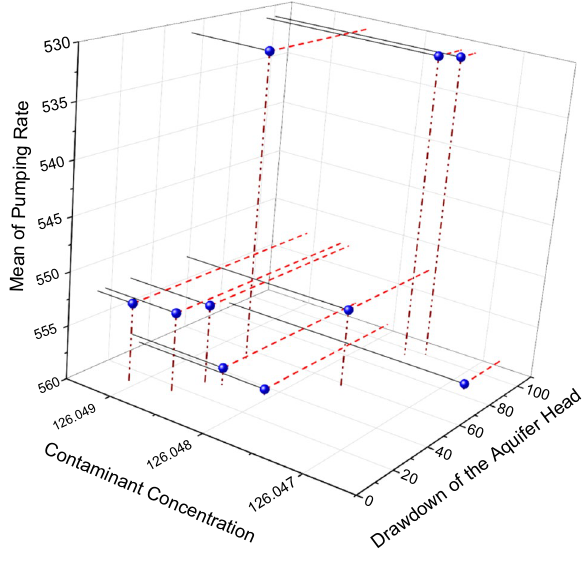
Fig. 17 Pareto front of NSGA-II algorithm (Real Case Study)